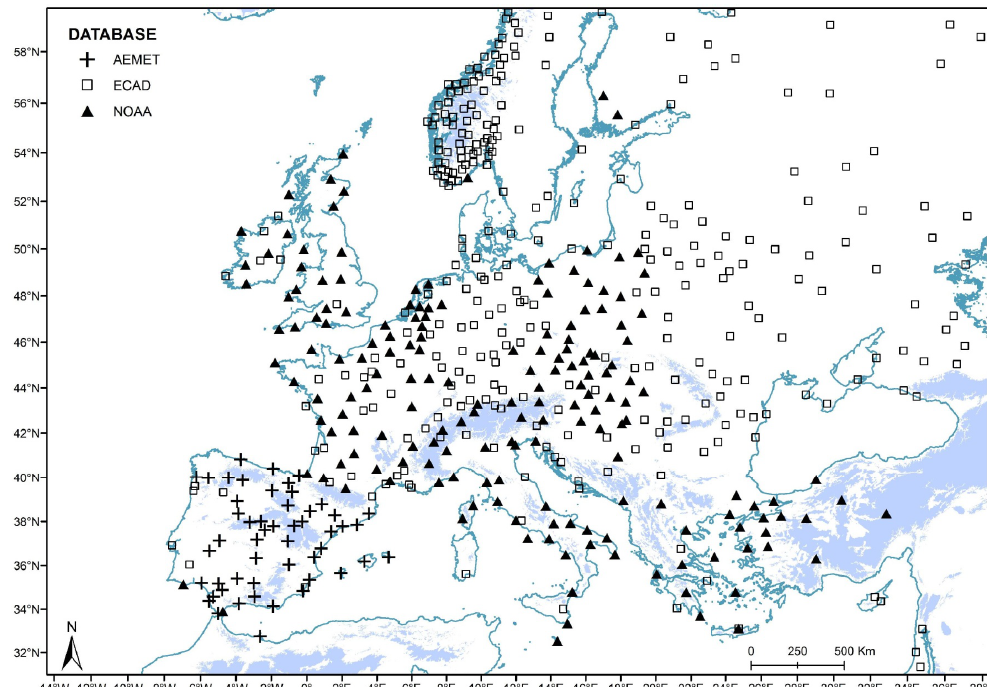
Fig. 1. European rain gauge network after quality